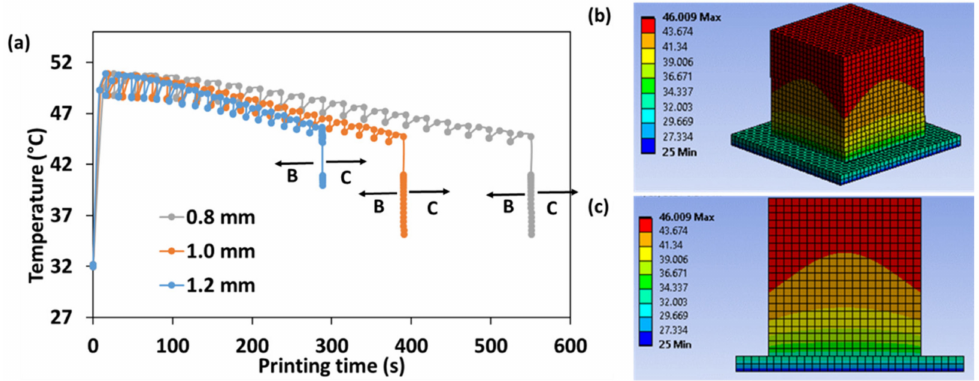
Figure 15. Simulated temperature distribution for the additive 3DP for rice paste (100:80): ( a ) topview component structure after the buildup phase, and ( b ) sideview component structure after the buildup phase ( c ).